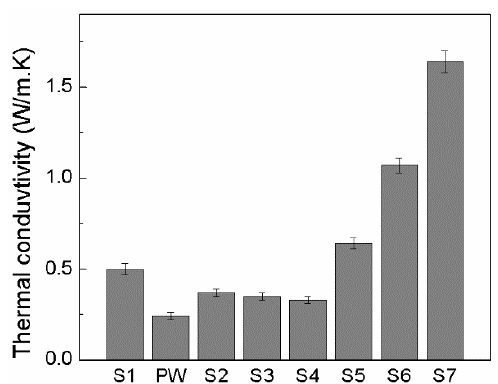
Figure 5. Thermal conductivity of pure components compared to prepared PCMs.